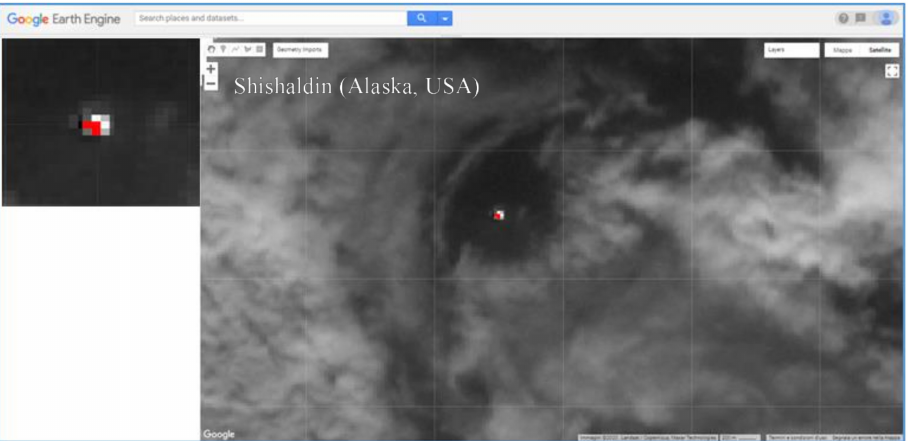
Figure 10. Thermal anomaly map from ASTER scene of 7 September 2001 at 22:16 UTC showing a thermal anomaly over the Shishaldin volcano. In background, the SWIR band 5 image; on top left side of the map, the detected thermal anomaly (in